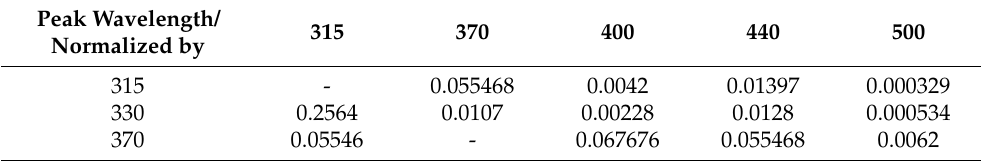
Table 1. The magnitude of the error of the second kind ( p -value) for the Mann–Whitney U test for samples of two cohorts: ruptured and non-ruptured aneurysms at a radiation wavelength of 250